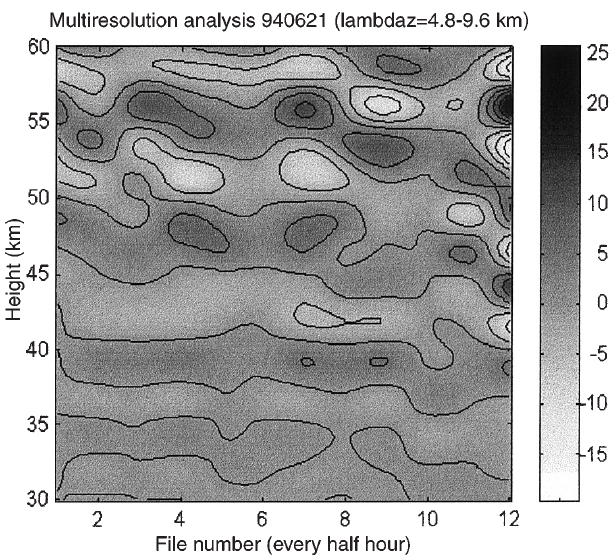
Fig. 7. The time and spatial evolution of the dominant wavelike patterns with 4.8–9.6 km vertical wavelengths (d MRA of successive 30-min integrated vertical temperature perturba- tion profiles for the night of June 21. A negative phase speed appears in the